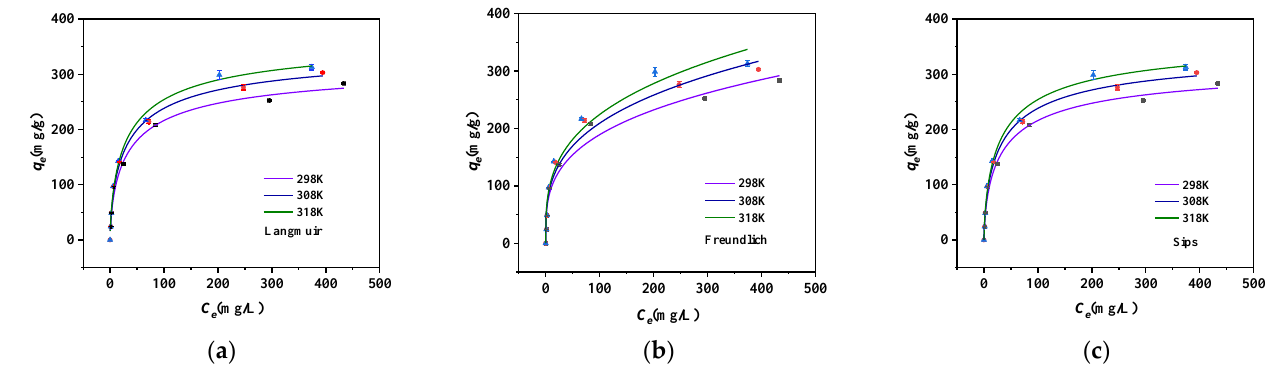
Figure 6. Adsorption thermodynamics study. ( a ) Langmuir model, ( b ) Freundlich model, and ( c ) Sips model. Table 3. Thermodynamic parameters of the